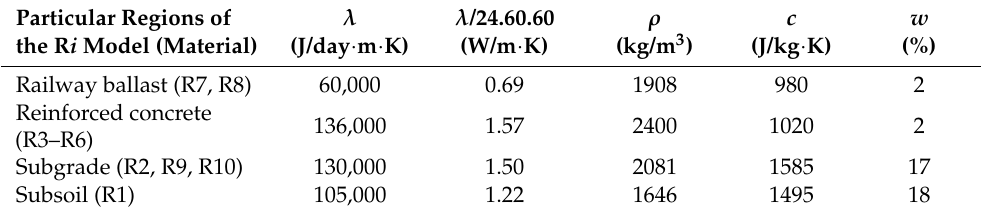
Table 1. Technical characteristics of structural layer